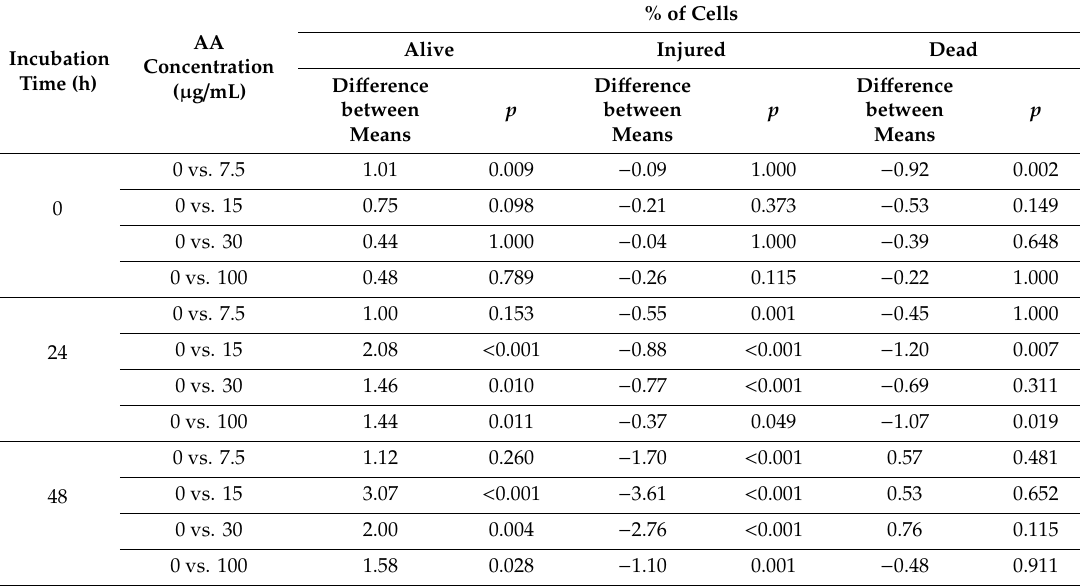
Table 7. The interaction e ff ect of incubation time and concentration of acrylamide on the viability of Lactobacillus plantarum (Bonferroni